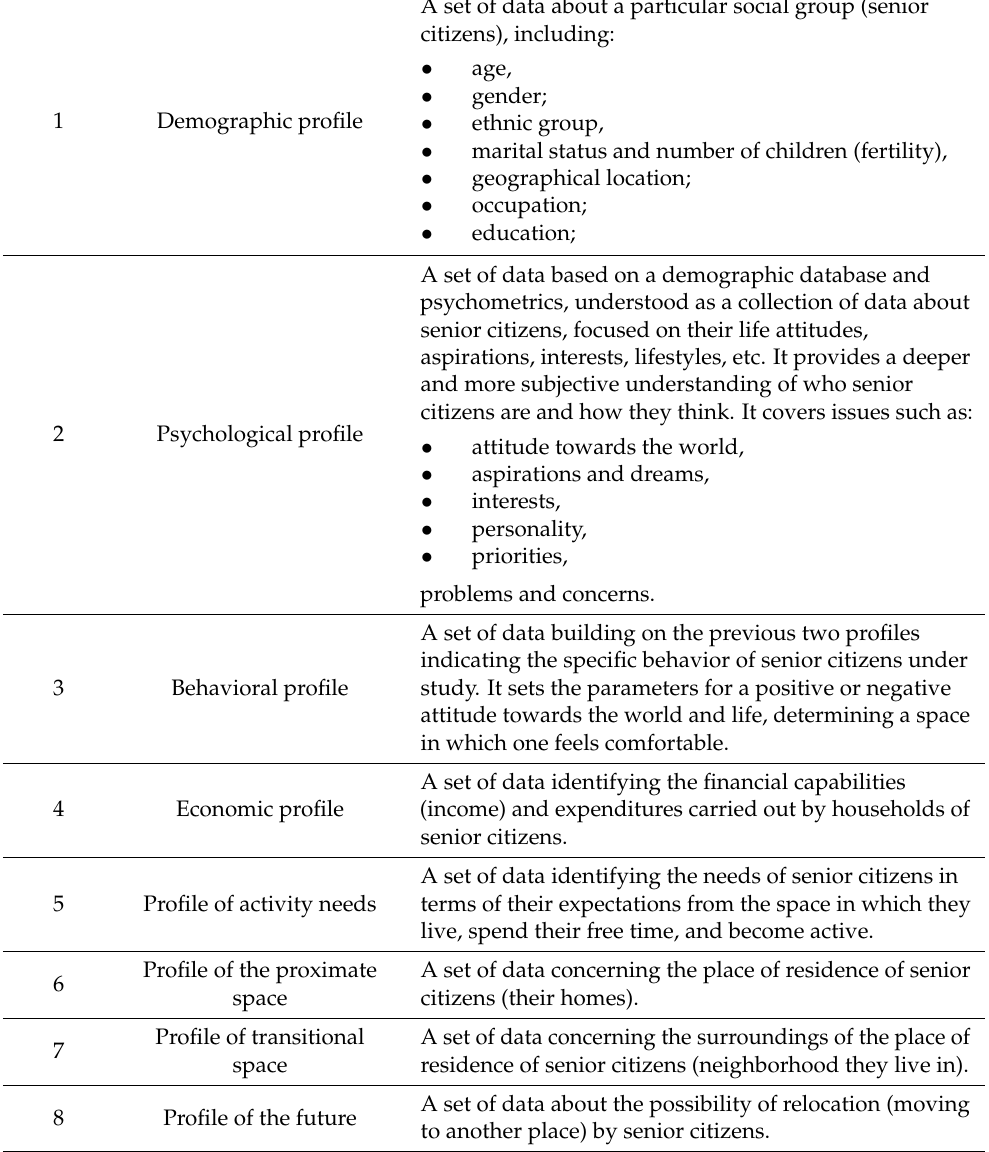
Table 4. Senior’s profile—categories. Source: own elaboration on the basis of [90–101]. No.